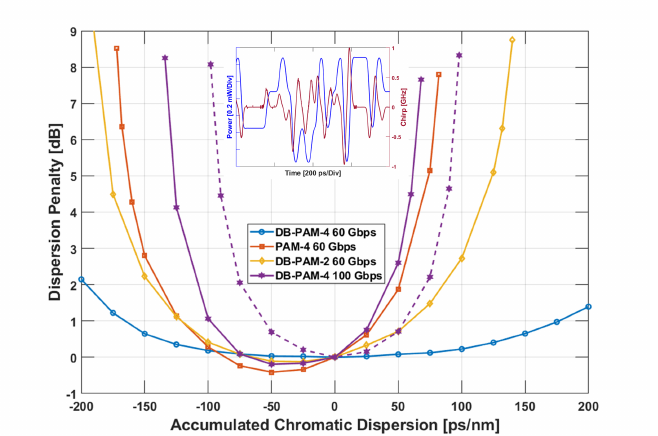
Figure 8. Simulated dispersion penalty as a function of accumulated fiber chromatic dispersion for different modulation formats and bit rates of 60 and 100 Gb/s employing the high BW system. The dashed line corresponds to the DB-PAM-4 100 Gb/s signal produced with a zero-frequency chirp transmitter. The inset shows the optical power (blue) of an 800 ps segment of the 60 Gb/s signal and its associated chirp (red) calculated just after the